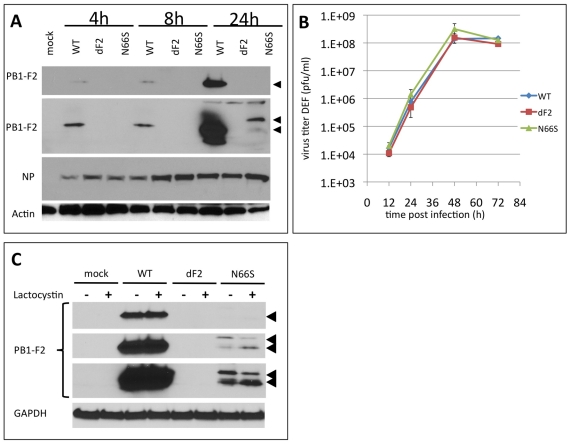
Effects of PB1-F2 expression on replication of A/Viet Nam/1203/2004 in duck fibroblasts in vitro.A) Time course of viral protein expression. Duck embryonic fibroblasts (DEF) were infected with 2MOI of A/Viet Nam/1203/2004 wild type, dF2 or N66S. Cells were lysed after indicated time points. Whole cell extracts were analyzed by western blot with specific antibodies against PB1-F2 (upper two panels, short and long exposure, respectively), viral nucleoprotein (NP) or beta-Actin. B) PB1-F2 expression in presence or absence of 10 µM lactocystin. DEF were infected with 2MOI of A/Viet Nam/1203/2004 wild type, dF2 or N66S. Cells were lysed after 24 h. Whole cell extracts were analyzed by western blot with specific antibodies against PB1-F2 (upper three panels, short, medium and long exposure, respectively, PB1-F2 is indicated by black arrows), equal loading is indicated by GAPDH levels (lower panel). C) Multi-cycle growth curve of A/Viet Nam/1203/2004 wild type (blue), dF2 (red) or N66S (green) on DEF. Cells were infected with 0.05MOI of virus. Viral supernatants were taken at the indicated time points. Viral titers were determined by standard plaque assay on MDCK in absence of trypsin. Mean pfu/ml of independent triplicates ±SD indicated by the error bar are depicted.